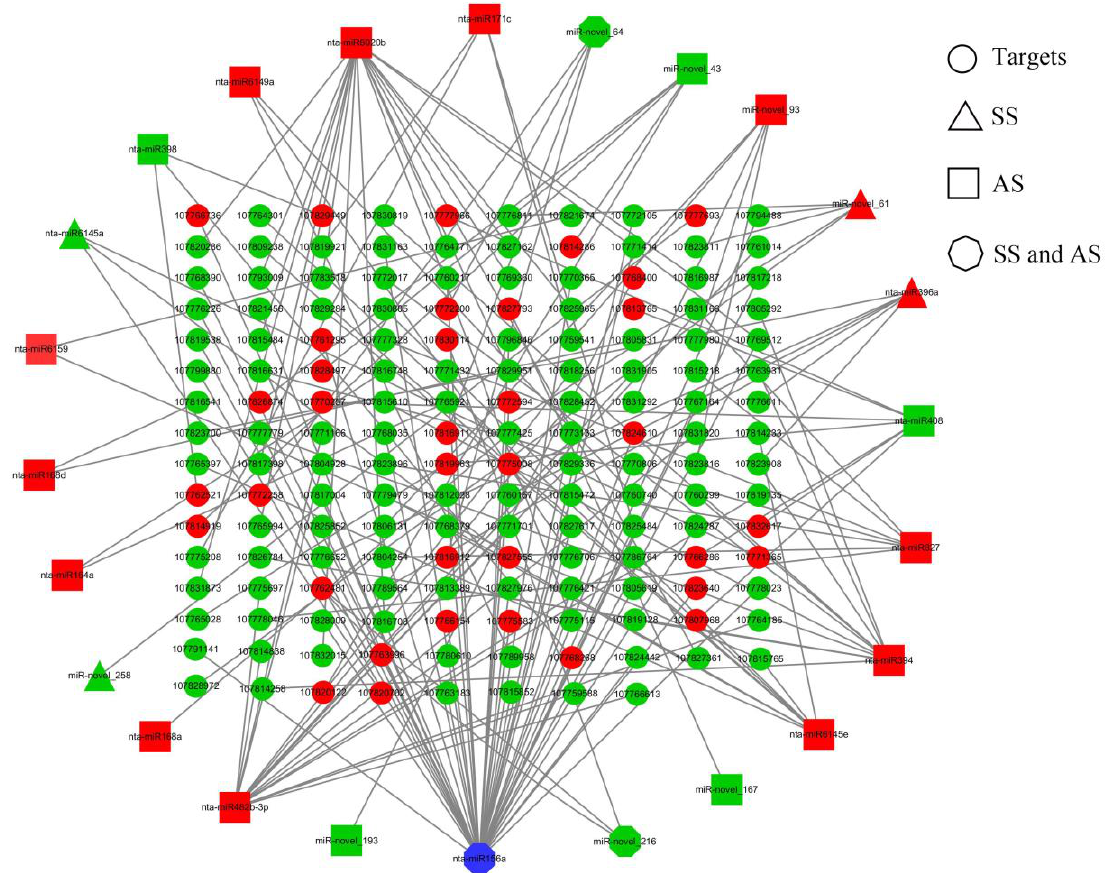
Figure 4. miRNA-mRNA correlation network. The circles in the network indicate the target mRNAs. The triangles, squares and octagons in the network indicate the DE miRNAs regulated by the SS, AS, and SS and AS treatments, respectively. Downregulated mRNAs and miRNAs are shown as green, and upregulated mRNAs and miRNAs are shown as red. Differential expression regulation by both SS and AS is shown in blue.